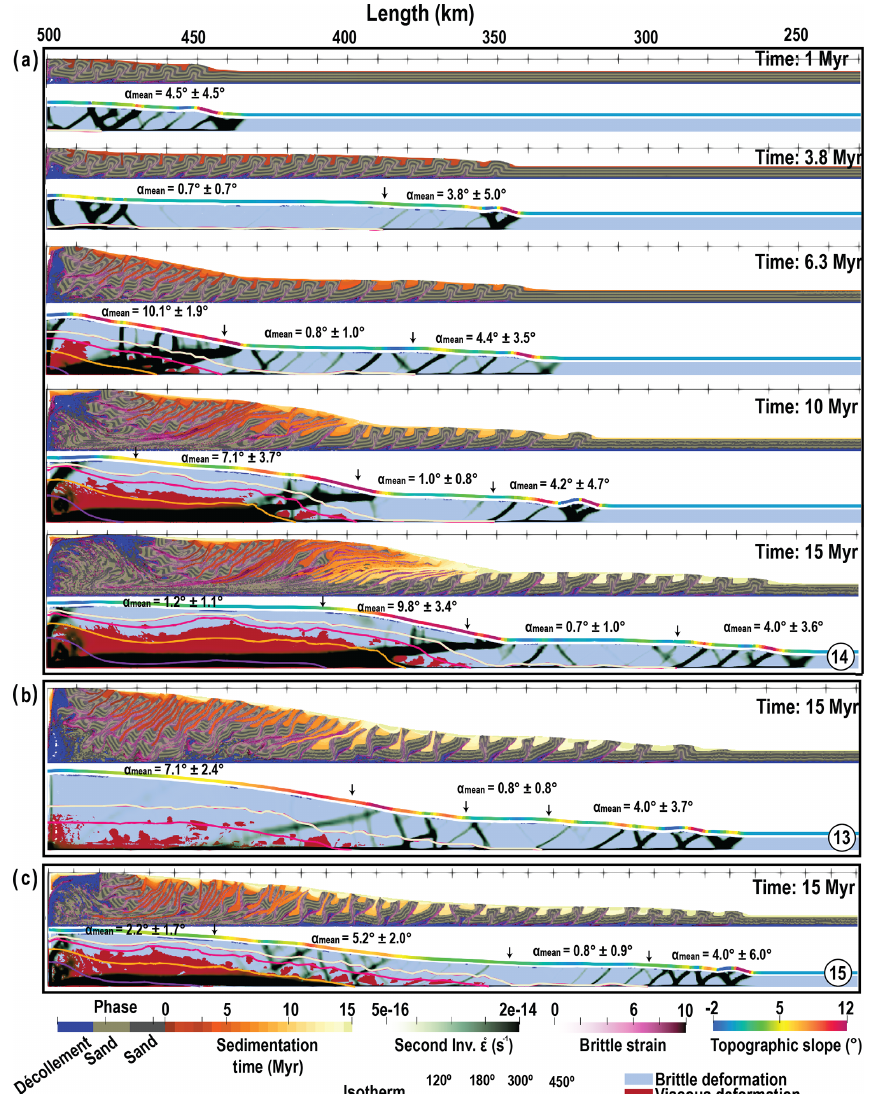
Figure 8. (a) 15Myr of time evolution of simulation M14 with dehydration reaction and shear heating. (b) Model at 15Ma for similar simulation without shear heating M13 . (c) Model at 15Ma for similar simulation M15 with 5 ◦ friction instead of 10 ◦ friction after the end of dehydration reaction, 1:1